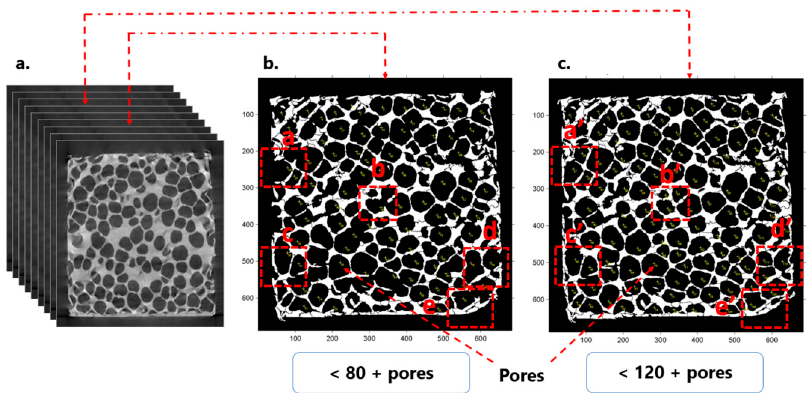
Figure 3. 2D tomography images of the closed-cell aluminum foam samples (Aluhab foam): ( a ) CT scan images; ( b ) and ( c ) random position images, selected from the range of images generated during CT scanning, showing the differences in pore sizes and arrangements, and cell wall thicknesses throughout the 3D volume of the foam sample.